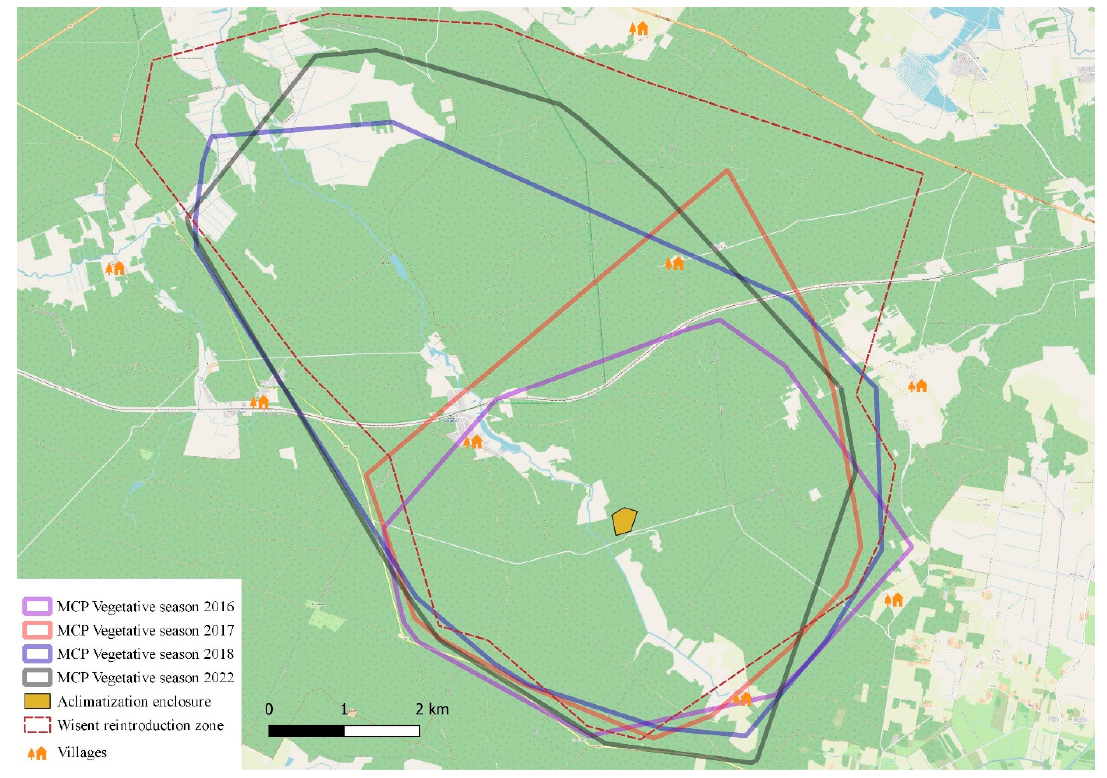
Figure 4. Minimal convex polygon areas during growing seasons.